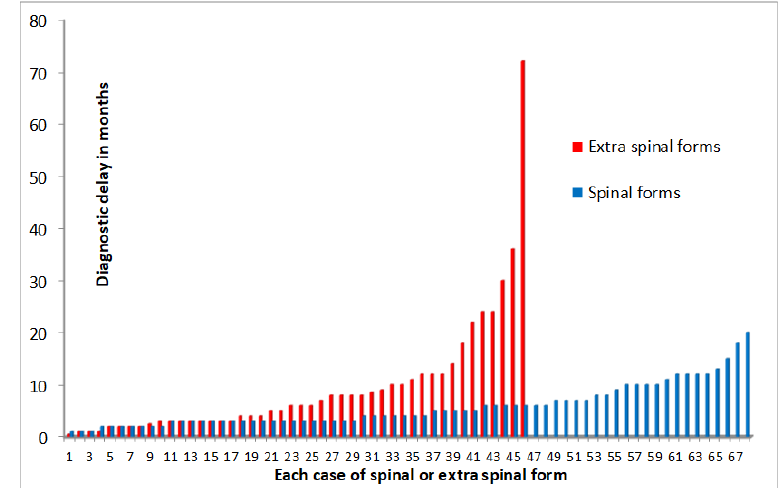
Figure 2. Diagnostic delay according to spinal or extraspinal BJTB forms. ESTB long diagnostic times: 72-month duration in an 80-year-old man with greater trochanter bursitis; 22-month and 24-month durations in elderly patients with a hip and a shoulder prosthesis infection, respectively; 36-month, 30-month and 24-month durations in patients with a rare clinical